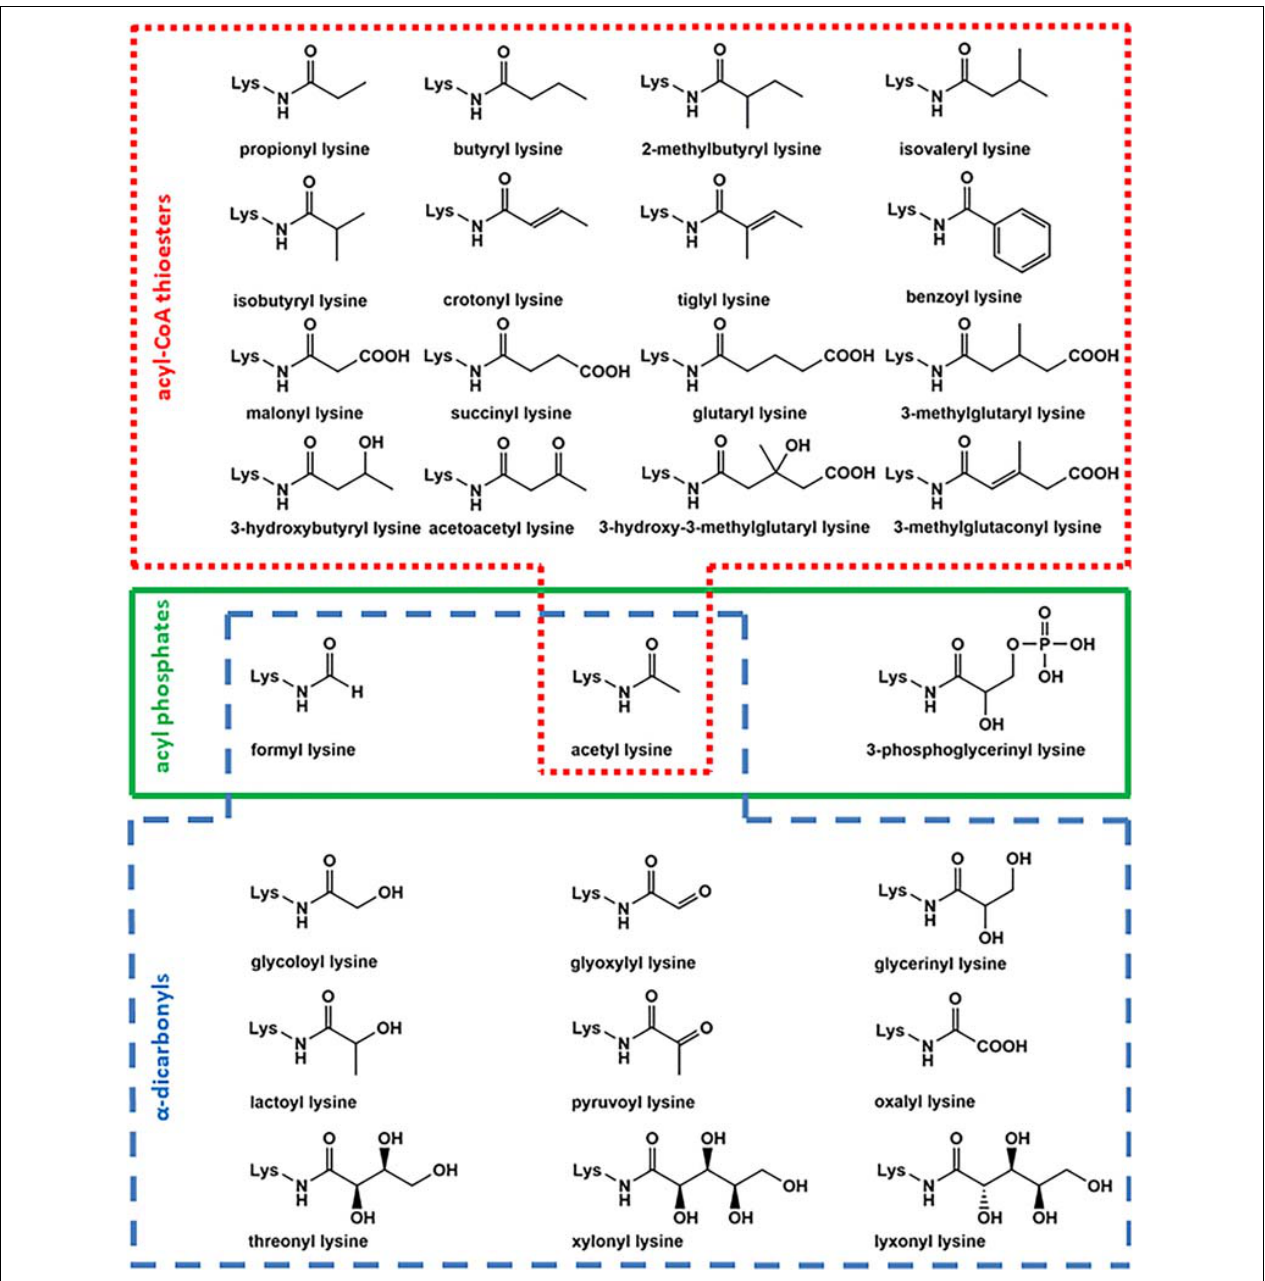
FIGURE 1 | Overview of acyl lysine modifications. Several posttranslational modifications are formed by reaction of lysine with acyl-CoA thioesters (red box), acyl phosphates (green box), and α -dicarbonyls (blue